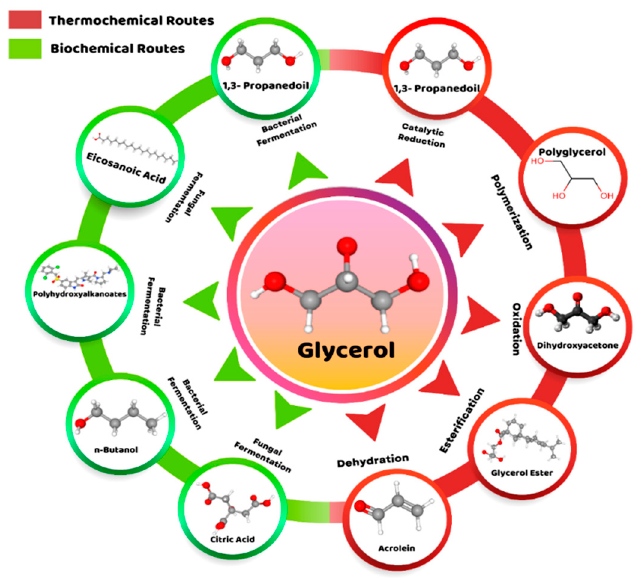
Figure 1. Thermochemical and biochemical routes.